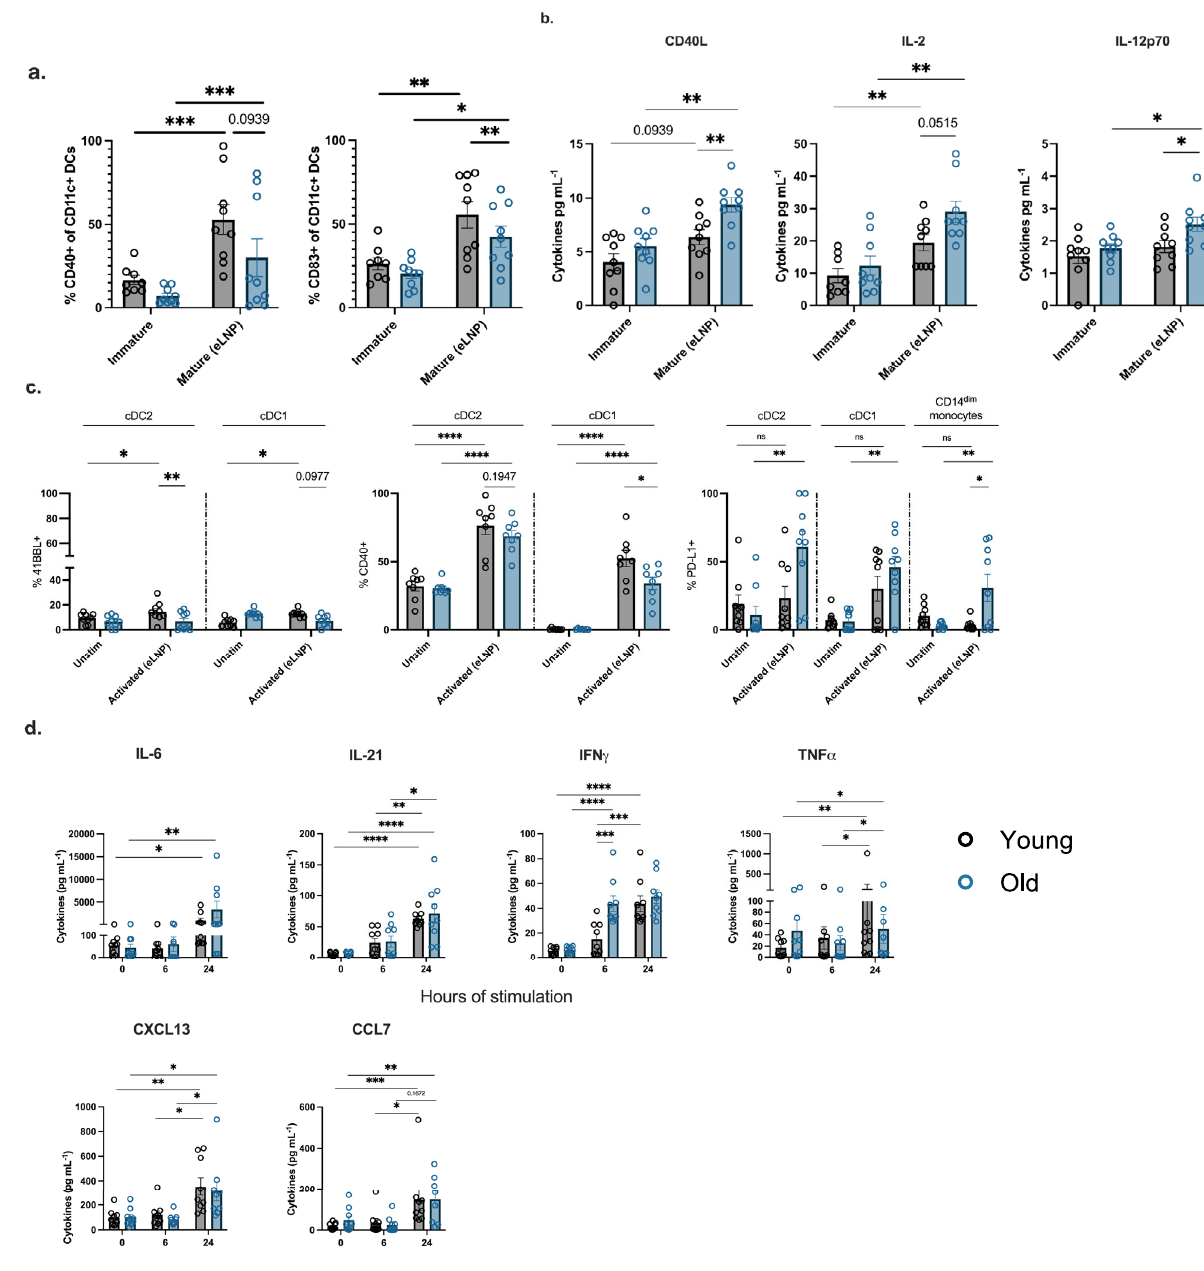
Fig. 5 eLNP treatment promotes monocyte-derived DC maturation and the secretion of pro-TFH cytokines that are also diminished between young and older participants. a – d Monocyte-derived dendritic cells (MDDCs) differentiated in vitro from monocytes of healthy human PBMCs from older and younger donors, were treated with 15 μ g/mL (total lipids, or ~7.5 μ g/mL ionizable lipid) eLNP for 24 h and compared to unstimulated cells (just media) as controls. MDDCs were harvested and stained for surface HLA and costimulatory molecule expression and analyzed by fl ow cytometry. Values are shown as the frequencies of ( a ) CD83, ( b ) CD40, ( c ) CD86 ( d ) HLA-DR in the live, CD3- CD19- CD11c + MDDC population. Supernatants were also harvested, and selected cytokines were measured with Luminex after 24 h of stimulation ( a – d ). Nine samples per group were measured, except 24 h LPS where only three samples per group were analyzed. Results are expressed as mean ± SEM of 2 independent experiments ( n = 9). Each individual circle represents